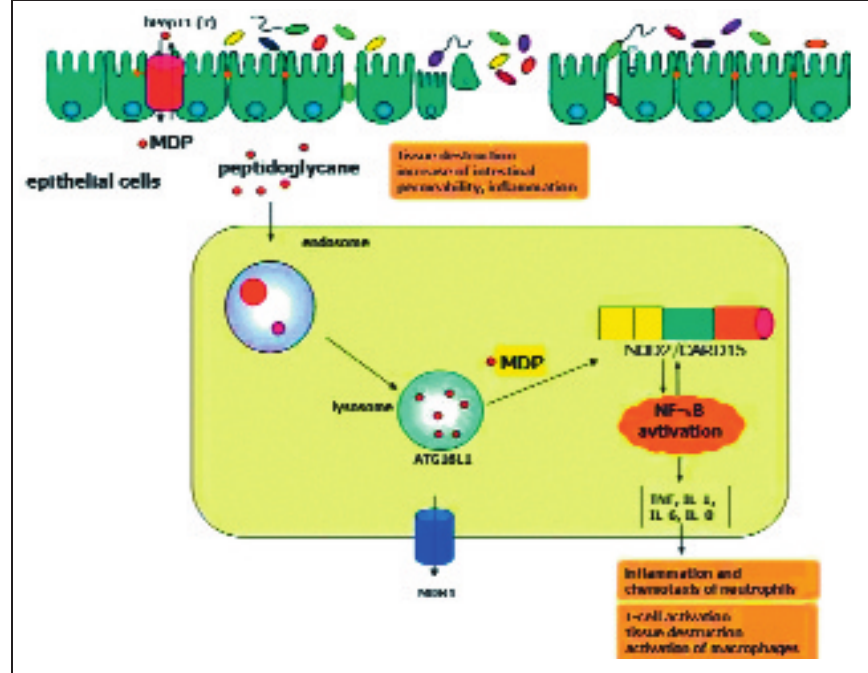
Pathophysiology of IBD: Barrier function and innate immune defense against invading pathogens are altered in CD. After active uptake via peptide transporter hPepT1 or other mechanisms, peptidoglycans are taken up and degraded by the endo-lyso- some. Variants of endolysolomal proteins (such as ATG16l1) have been shown to be associated with susceptibility to develop CD. MDP binds to the NOD2/CARD15 protein thereby activating NF κ B and consequently inducingTNF, Il-1, Il-6, and Il-8 secretion. NOD2 variants are less effec- tive in binding MDP and do not activate the in- nate immune systems as effective as wildtype NOD2. In summary, the genetic variants asso- ciated with an increased risk to develop CD cause a less effective reaction to invading bac- teria and bacterial